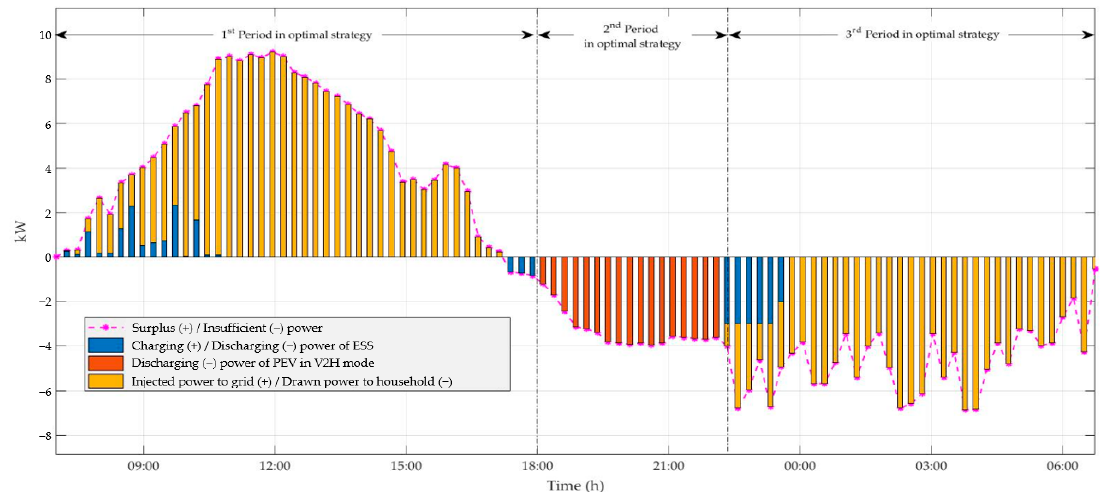
Figure 9. Daily power generation of the solar PV system and household load profile.